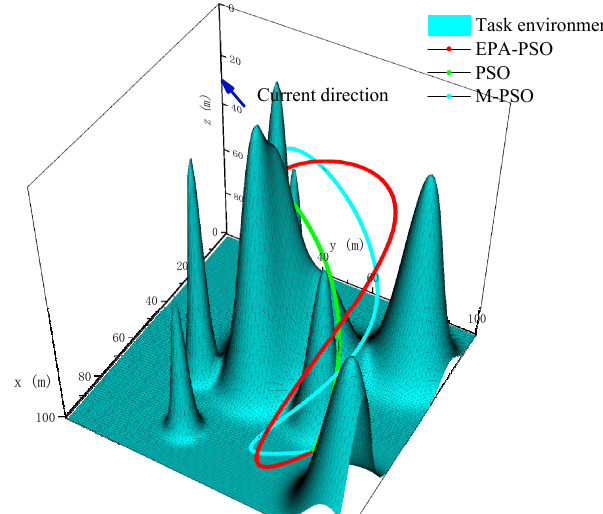
Figure 22. 3D path planning after 100 iterations.